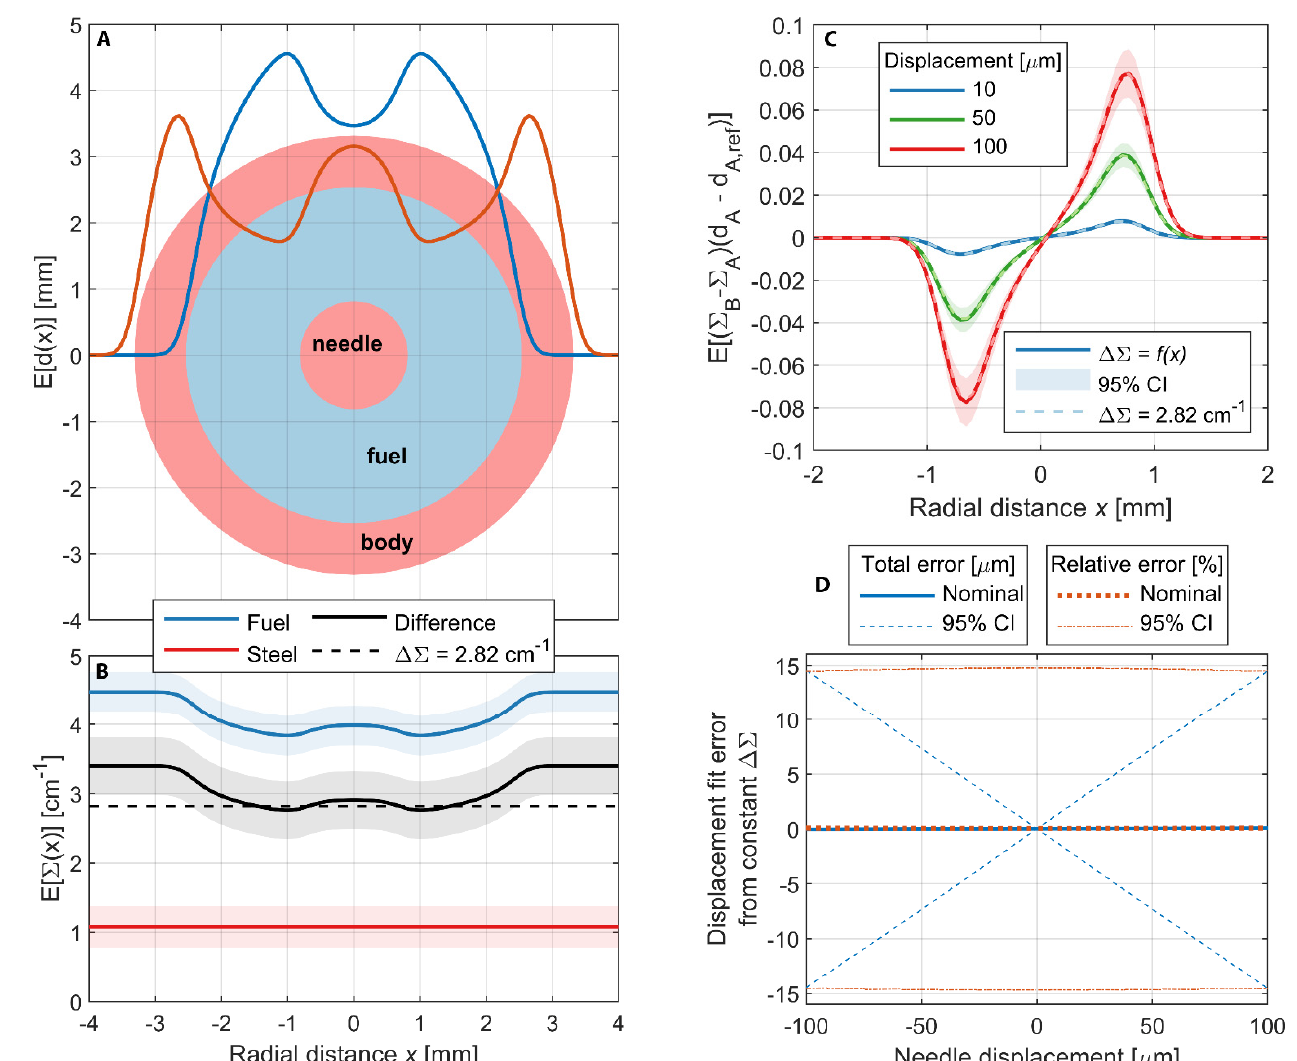
Figure A3. Investigation of beam hardening effects. ( A ) Cross section of fuel and injector system with position-dependent expected path length. ( B ) Position-dependent expected value of attenuation coefficient in each component. Shading indicates 95% confidence interval from attenuation coefficient fits. ( C ) Model of expected value in log-ratio normalized images due to displacement of injector needle show that position-dependent and constant ∆Σ are virtually indistinguishable. ( D ) Error from use of constant ∆Σ in displacement fitting model is negligible over the range of displacements expected in this system. Confidence interval for relative error due to uncertainty in attenuation coefficient fits is roughly constant at ±15%.